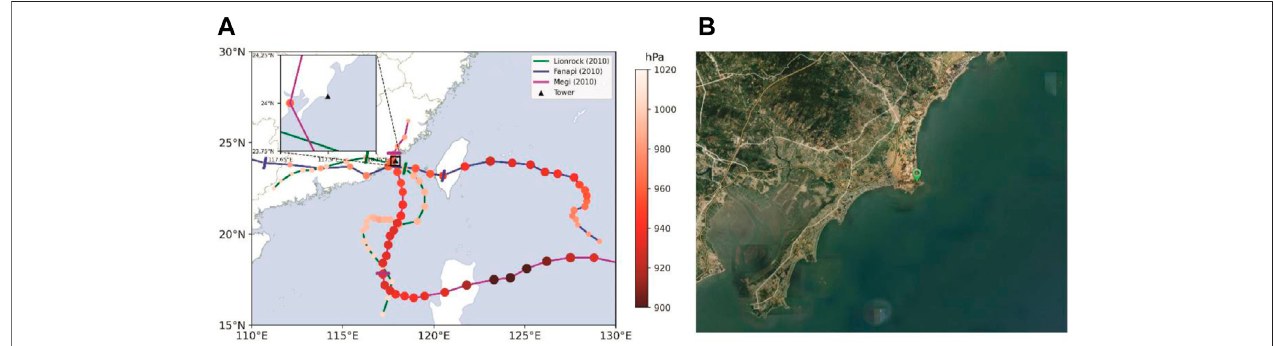
FIGURE 1 | (A) Tracks of Lionrock (green curve), Fanapi (blue curve), and Megi (purple curve). Dots show the storm center positions every 6 h, with the minimum central pressure indicated with colors. The time analyzed is the time encompassed between the two short crosses on each track. The site of the observational tower is indicatedbytheblacktriangle.Anenlargedviewofthetowerpositionisalsopresentintheupper-leftcorne. (B) Thegroundenvironmentsurroundingthetower,withthe light green sector symbol marking the tower